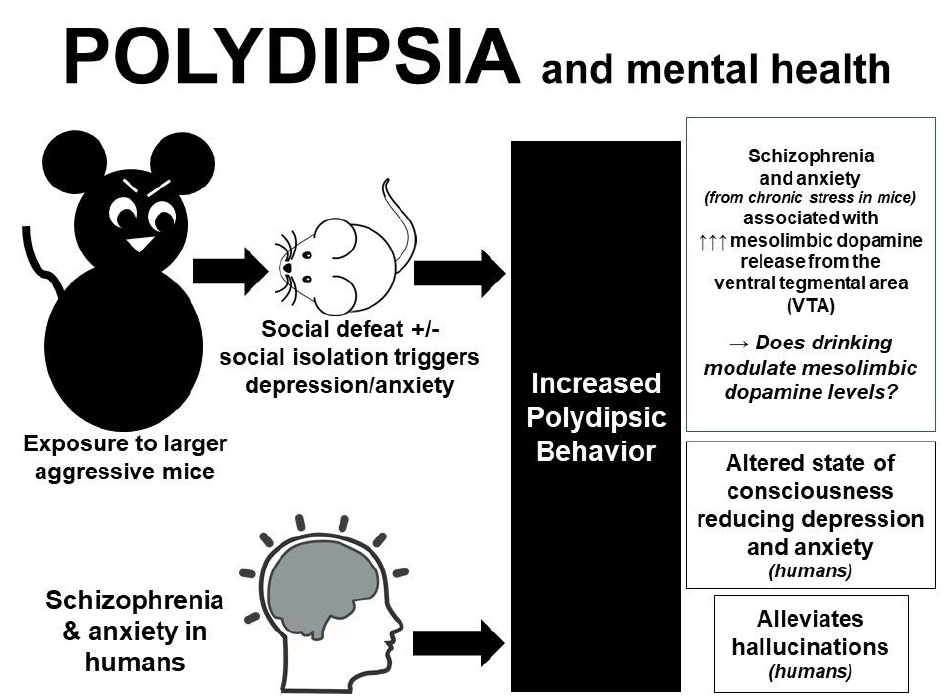
Figure 1. Summary of data obtained from mice and humans linking polydipsia to mesolimbic reward centers, which serve to reduce anxiety and/or signs and symptoms of psychiatric illness.